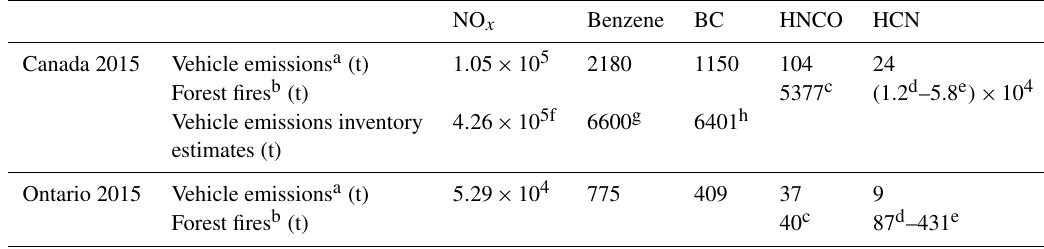
Table 5. Annual traffic pollutant emissions from the transportation sector and biomass burning for Canada and